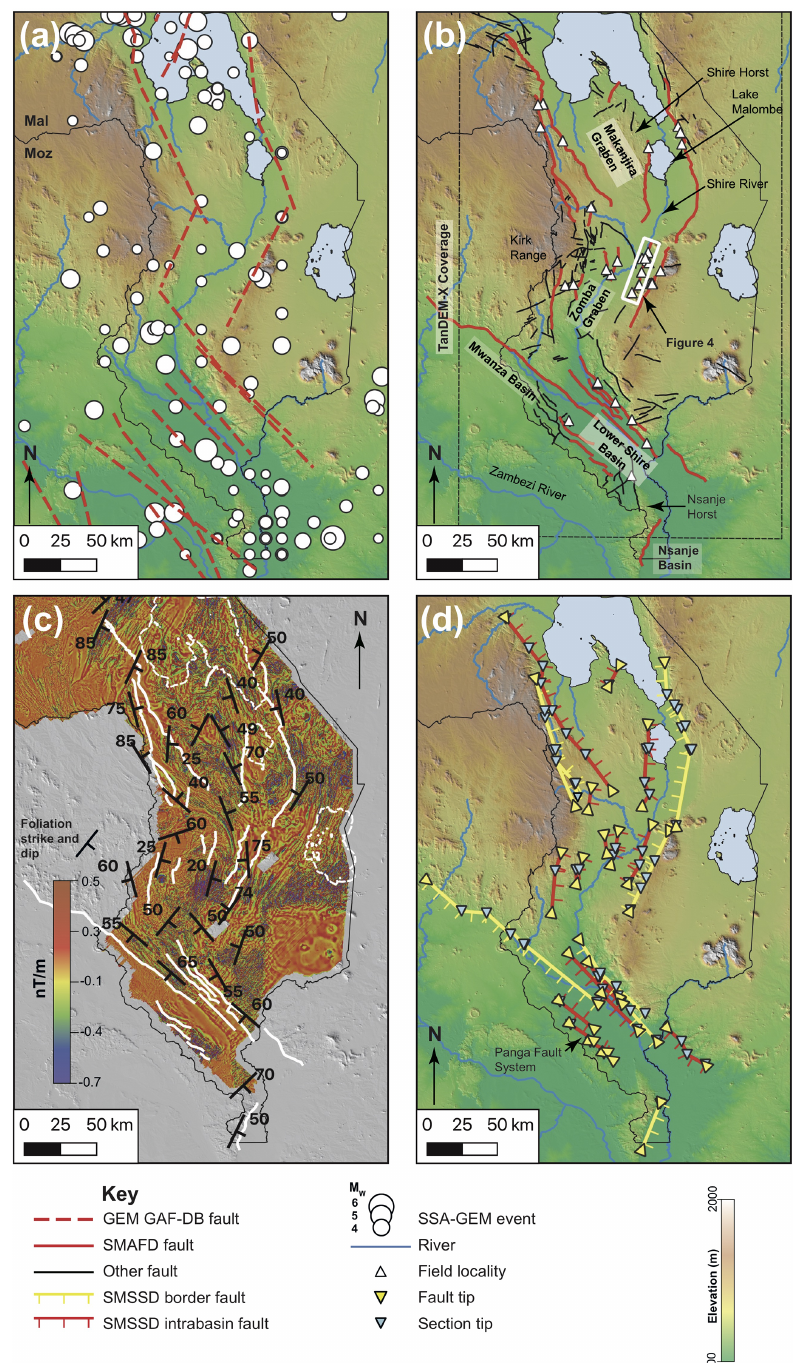
Figure 2. (a) Global Earthquake Model Global Active Fault Database map for southern Malawi (GAF-DB; Macgregor, 2015; Styron and Pagani, 2020). The sub-Saharan African Global Earthquake Model (SSA-GEM; Poggi et al., 2017) event locations are also shown. (b) Map of active fault traces compiled in the South Malawi Active Fault Database (SMAFD) with field locations and TanDEM-X coverage. Faults not interpreted to be active are also shown. (c) Aeromagnetic image created from the vertical derivative, with foliation orientations digitised from geological maps (Bloomfield, 1958, 1965; Bloomfield and Garson, 1965; Habgood et al., 1973; Walshaw, 1965). SMAFD faults shown in white and the outline of lakes are shown by dashed white lines. For full details of the acquisition of the aeromagnetic data, see Laõ-Dávila et al. (2015). (d) Simplified geometry of faults in the South Malawi Seismogenic Source Database (SMSSD), with faults sorted into border and intra-basin faults. Ticks indicate fault hanging wall. The extent of all maps is equivalent and is outlined in Fig. 1b. All maps are underlain by the SRTM 30m digital elevation model. “Mal” denotes Malawi, and “Moz” denotes Mozambique. Solid Earth, 12, 187–217,